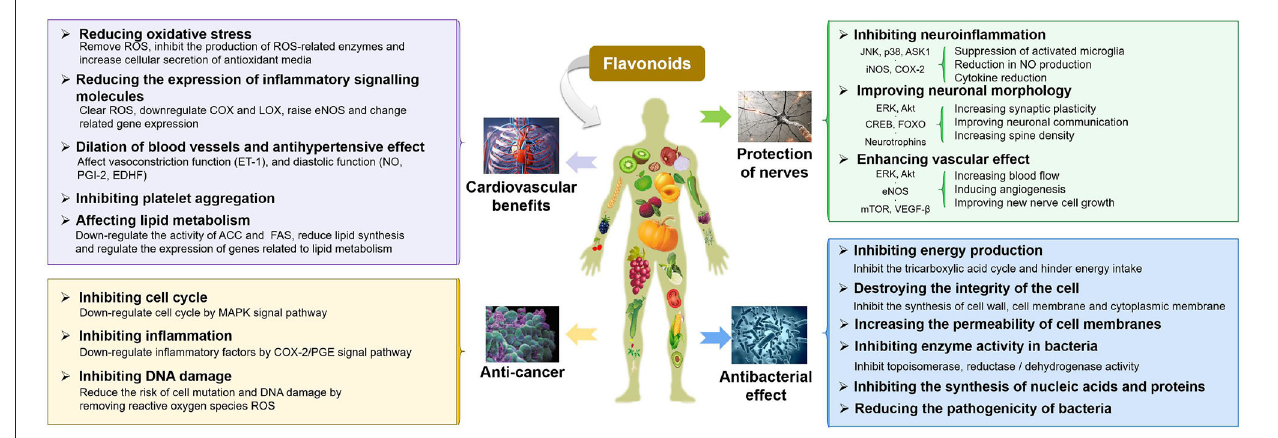
FIGURE 1 | A summary of physiological functions and their corresponding mechanisms of